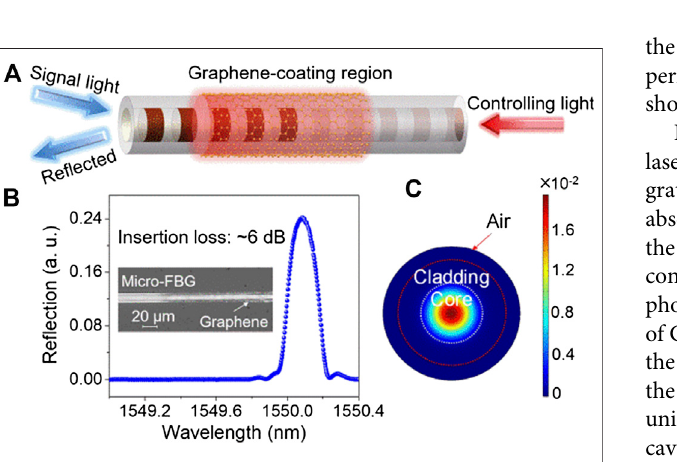
fl uctuation ranges are 0.005 nm and 0.5%, respectively, and the operation is stable. The tuning characteristics are shown in Figure 13 .